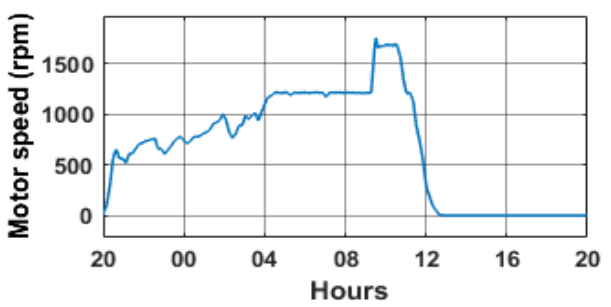
Figure 25. Motor speed of the heating system under PIOFL controller.